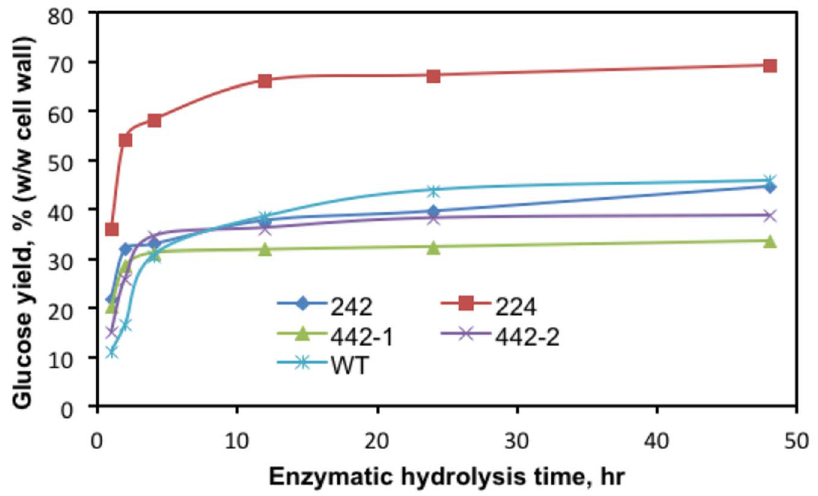
Fig. 5. Sugar release of wild type versus 224-EGFP , 242-EGFP , and 442-EGFP cell walls. Cell walls were digested with cellulase and glucosidase. The glucose contents in hydrolysis solution withdraw at time intervals of 1, 2, 4, 12, 24, and 48 hour were analyzed. The calibration of the system was performed with glucose standards. The 224-EGFP cell walls showed a better sugar release performance than 242-EGFP , 442-EGFP , and wild type cell walls.